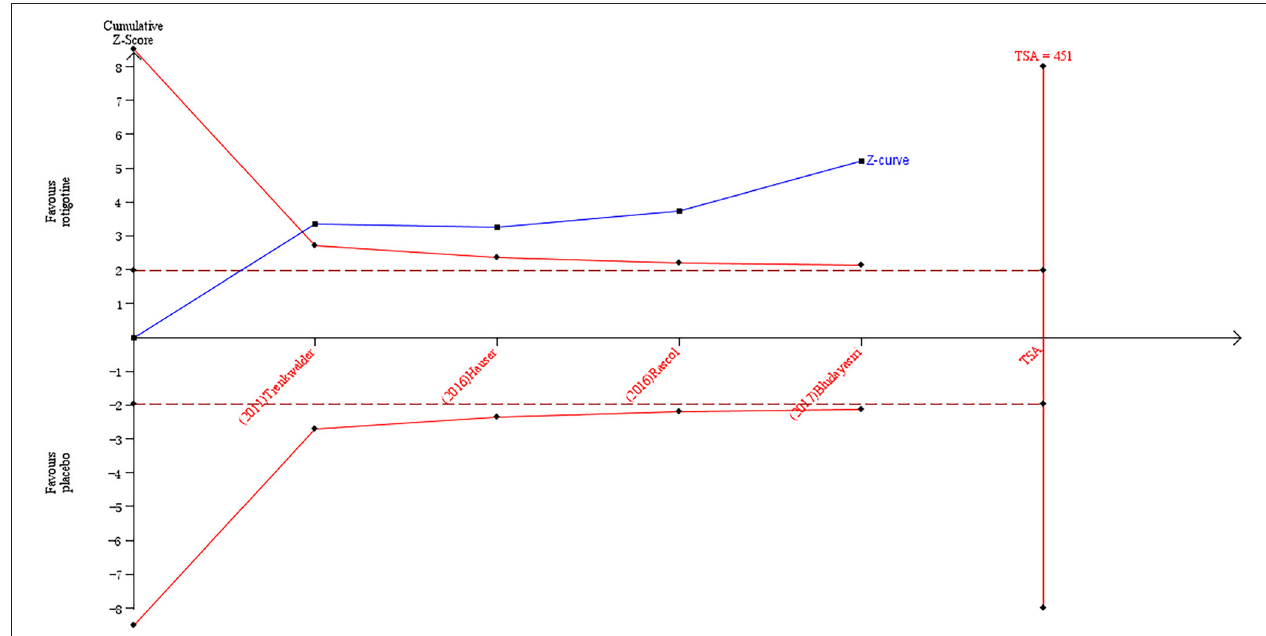
FIGURE 8 | Trial sequential analysis of the cumulative meta-analysis of the effect of rotigotine vs. placebo on PDQ-8 score in Parkinson’s disease patients.